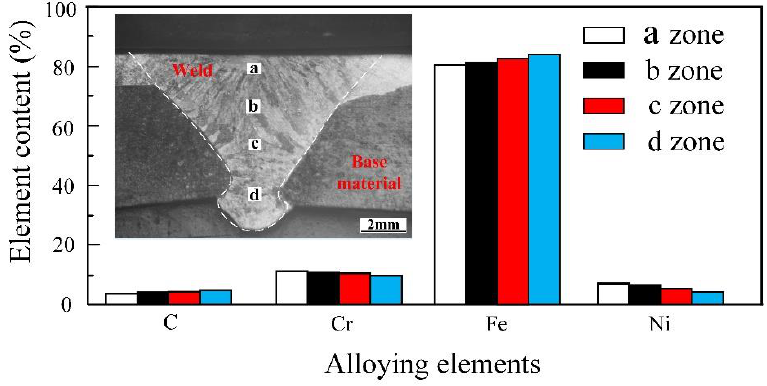
Figure 13. EDS spot scan of the upper weld and lower weld.